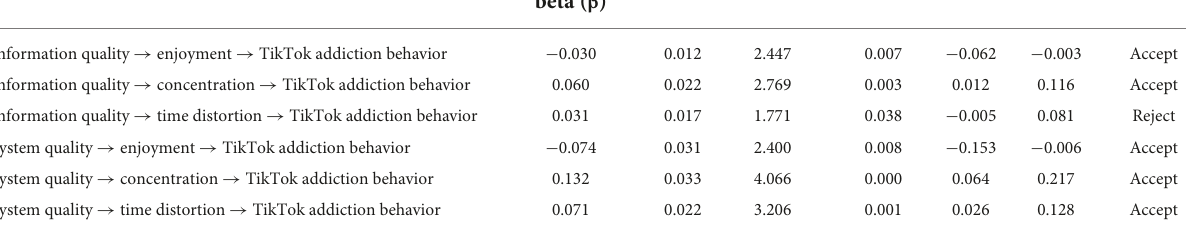
TABLE 6 Summary of mediation test effects.